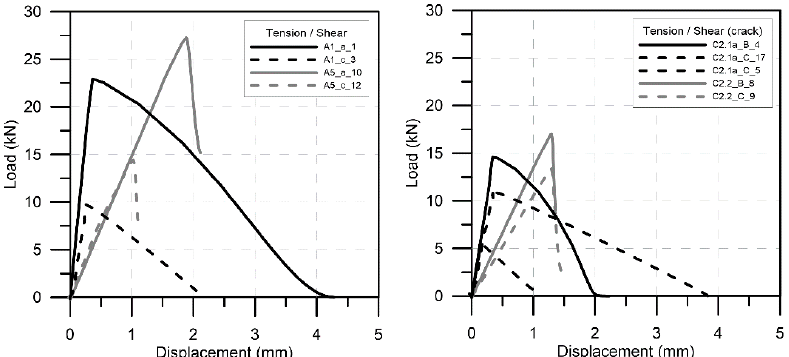
Figure 10. Comparison between tension and shear tests.